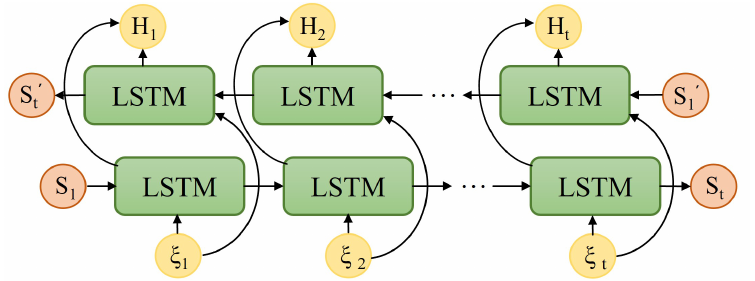
Figure 6. Standard structure of